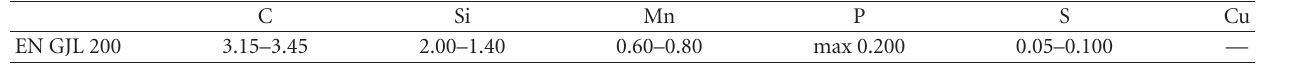
Table 1: Chemical compositon of material,